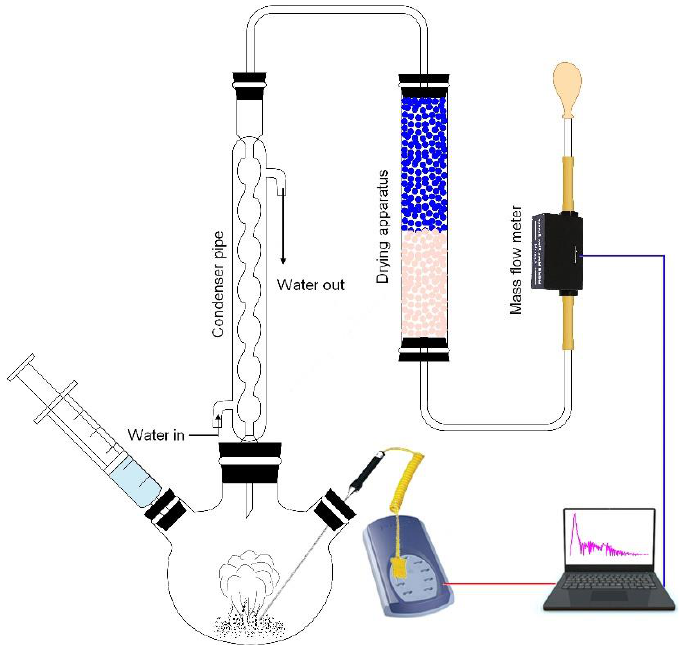
Figure 1. Schematic of the experimental setup for hydrogen generation.